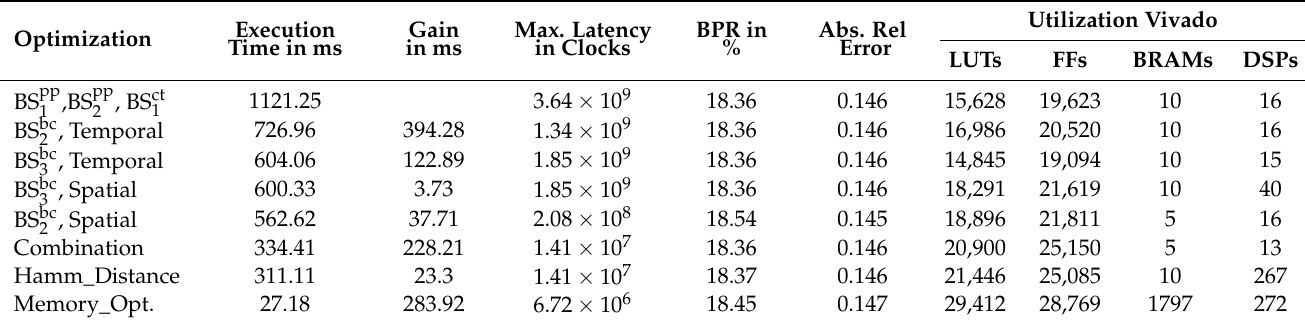
Table 3. Actual execution time, gain, utilization and error comparison